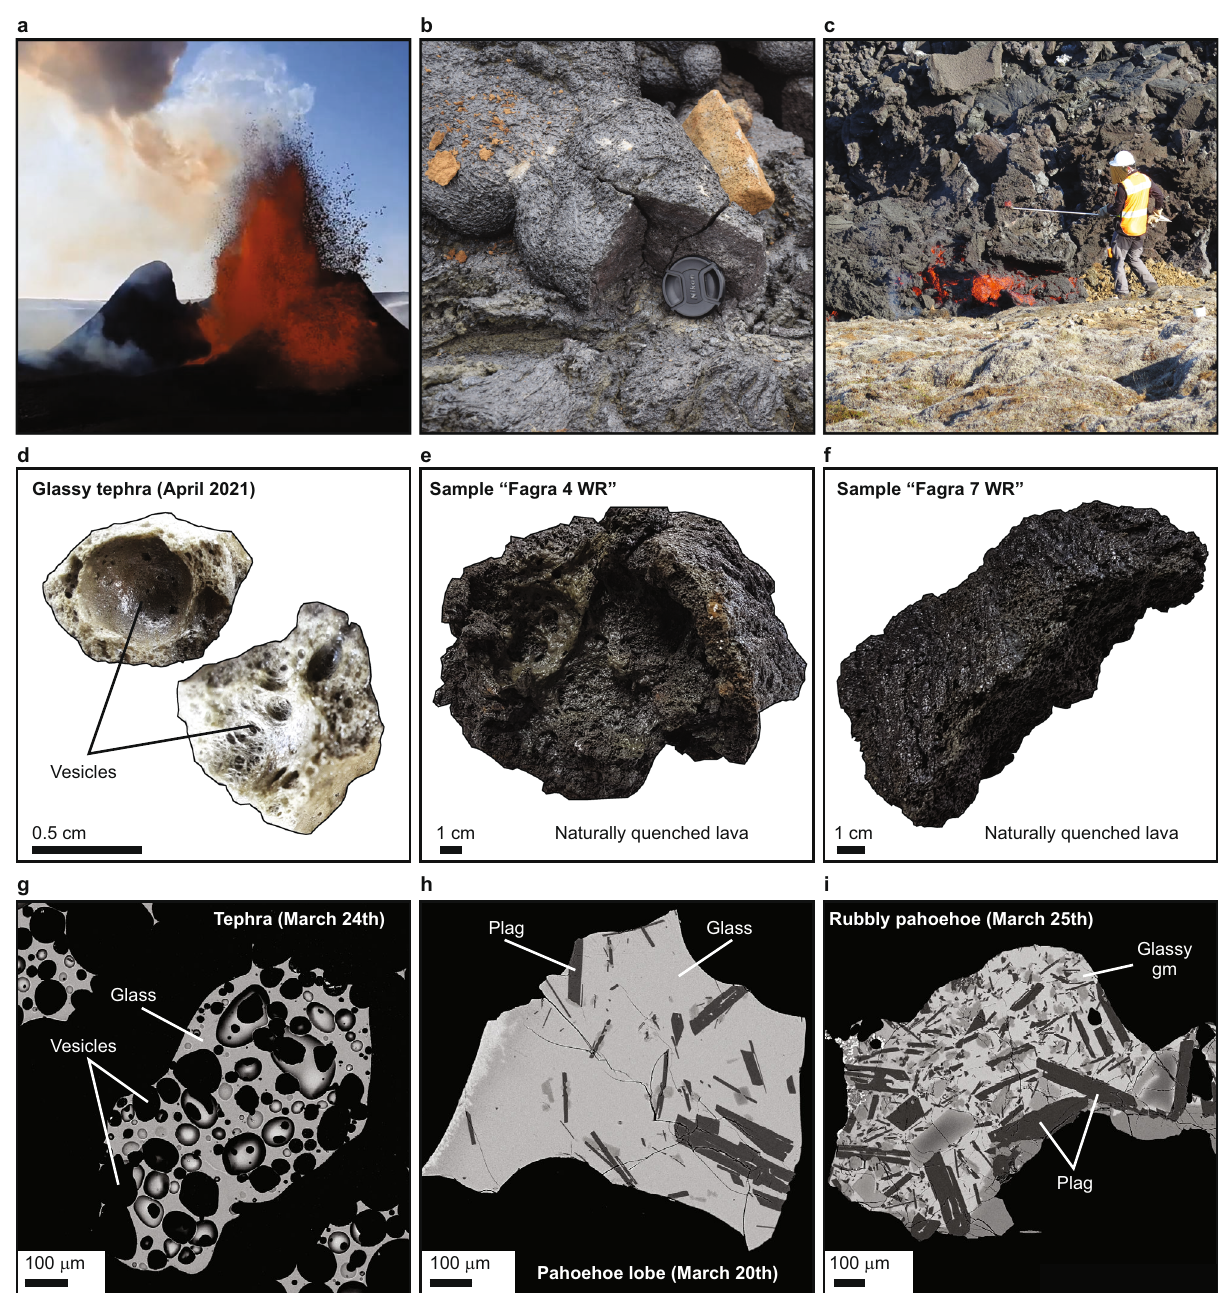
Fig. 2 Fagradalsfjall 2021 eruption and samples. a – c Photographs of various phases of activity during the Fagradalsfjall eruption in April and June 2021. a Typical lava fountaining during an eruption episode in May 2021. b Field appearance of a pahoehoe lobe. c Sampling at a rubbly pahoehoe lava front. d – f Hand sample photographs showing the typical appearance of tephra and quenched lavas employed in this study. g , h Back-Scatter Electron (BSE) images of early erupted products ranging from glassy, highly vesiculated tephra ( g ) to more extensively crystallised material characteristic of rubbly pahoehoe lavas ( i ). Abbreviations: Gm, groundmass; Plag,